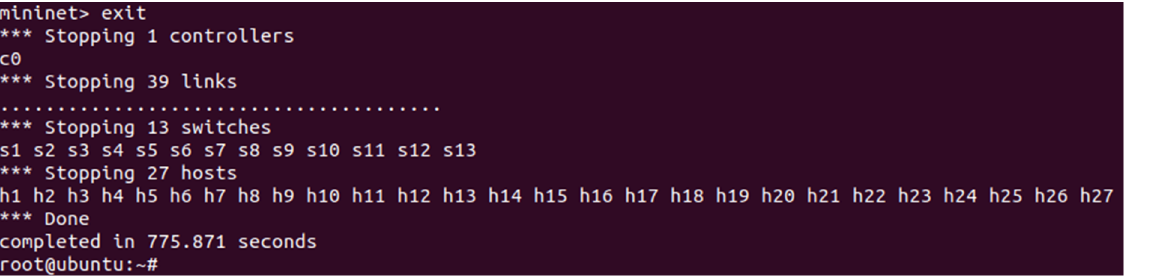
Figure 27. Tree topology: time to complete the procedure from start to finish with ODL controller.